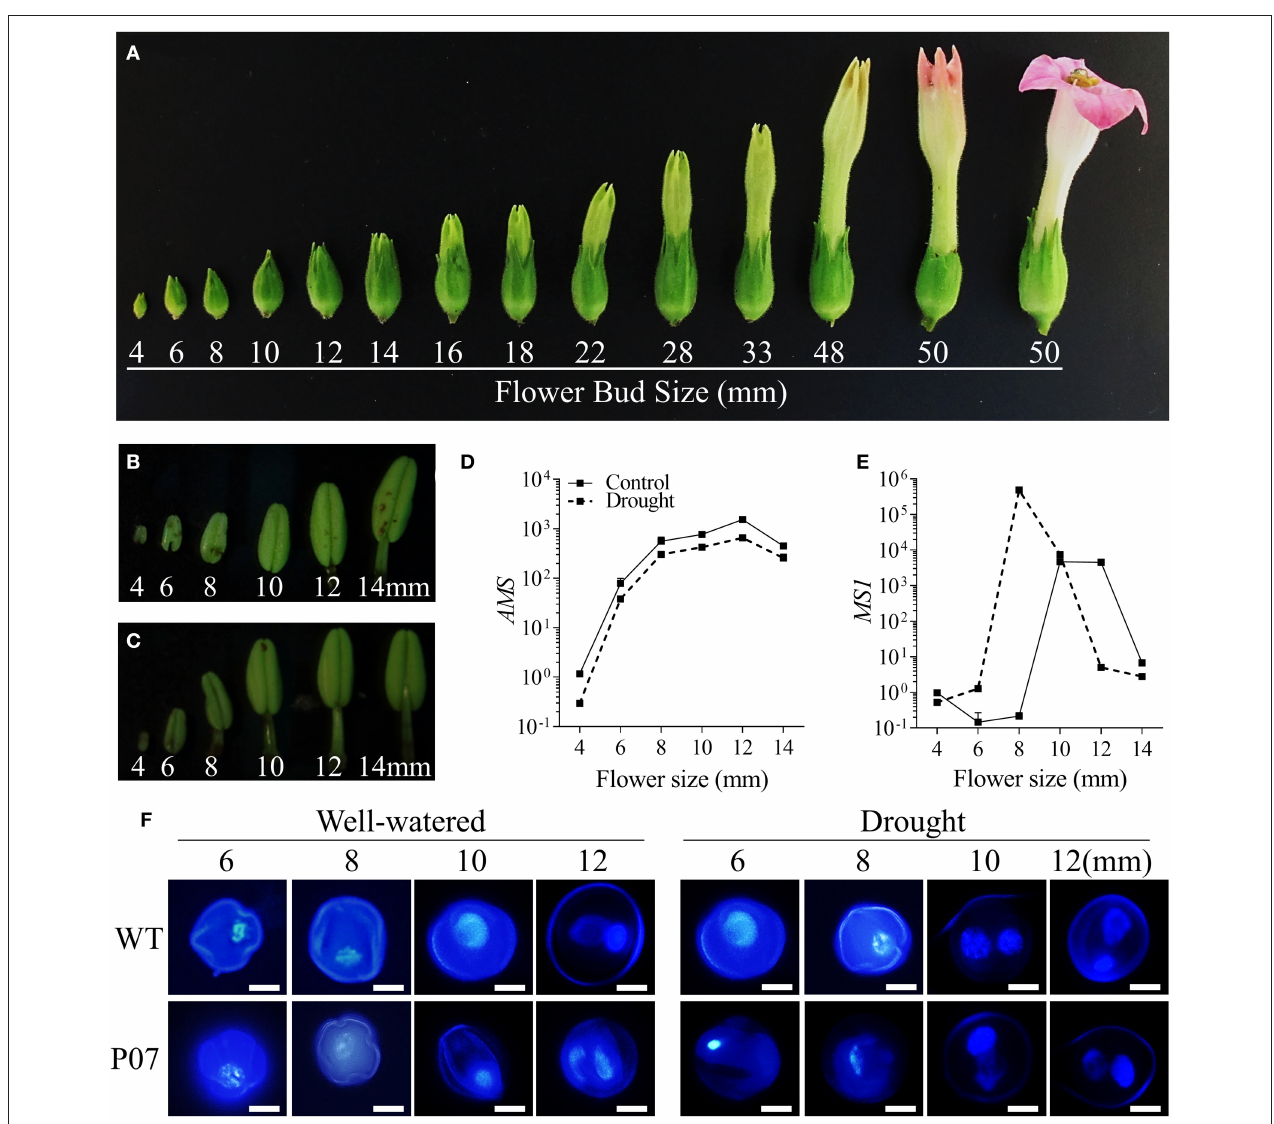
FIGURE 6 | Flower and anther development in tobacco plants. (A) Flower development was assessed in tobacco plants based on bud size. Focusing on the early stages of pollen development, anthers was isolated from 4 to 14mm buds from (B) control and (C) drought-stressed WT plants. The expression of (D) AMS and (E) MS1 was analyzed using qRT-PCR in control and drought-stressed WT plants to identify the key initial stages in pollen development. (F) Pollen grains of WT and transgenic line P07 were stained with DAPI to determine correlations between bud size and pollen stage in control and drought-stressed plants. Scale bars = 10 µ